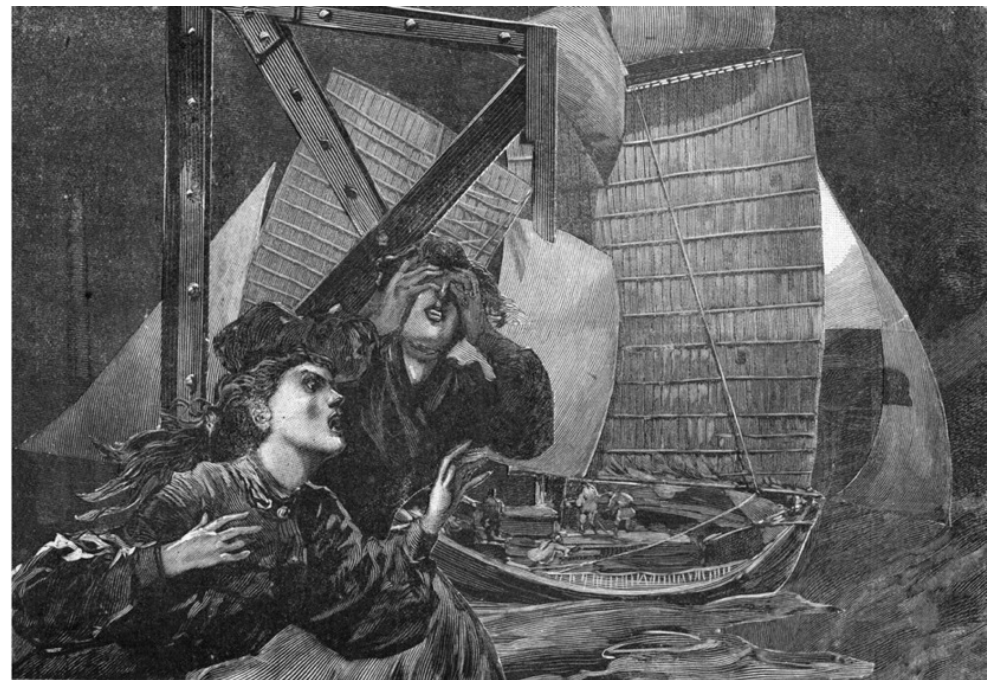
Figure 9. (a) Paper Collage comprized of original engravings from La Grande Illustré (1904); ( b ) Extract from Un Coup des Dés; NOTHING/ of the memorable crisis/where the event/ matured accomplished in sight of all non-existent/human outcomes/ WILL HAVE TAKEN PLACE